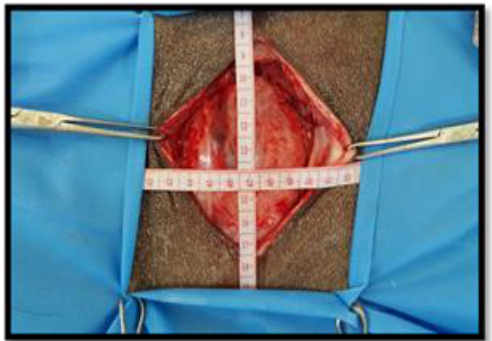
Figure, 1: Shows hernia ring after excision of abdominal wall